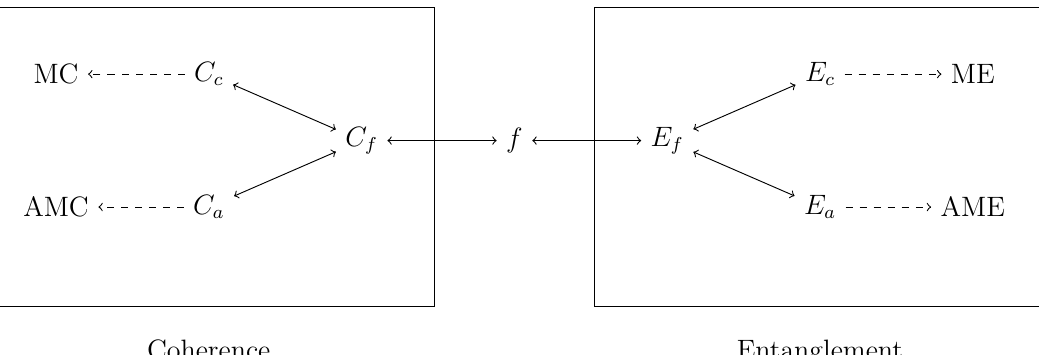
0 F E f is a function defined on bipartite Figure 1. Relations between coherence and entanglement. Here f ∈ \{ } . pure states as in Eq. (1). C f is a function defined on pure states as in Eq. (4). E c is the entanglement measure called the entanglement of convex roof which is the convex roof extension of E f from pure states to mixed states in Eq. (2). C c is the coherence measure called the coherence of convex roof which is the convex roof extension C f of from pure states to mixed states in Eq. (5). E and C are one-to-one corresponded by the real symmetric c c concave function f . The maximum points of E and C are maximally entangled states (ME) in Eq. (3) and c c maximally coherent states (MC) in Eq. (6) respectively. E a is the entanglement of assistance which is the least E f concave majorant extension of from pure states to mixed states in Eq. (7). C is the coherence of assistance a which is the least concave majorant extension of C f from pure states to mixed states in Eq. (8). E and C a are a one-to-one corresponded by the real symmetric concave function f . The maximum points of E a and C a are assisted maximally entangled states (AME) in definition 2 and assisted maximally coherent states (AMC) in definition 1 respectively. The coherence of assistance C a as well as the entanglement of assistance E a is shown to be strictly larger than the coherence of convex roof C c and entanglement of convex roof E c for all full rank quantum